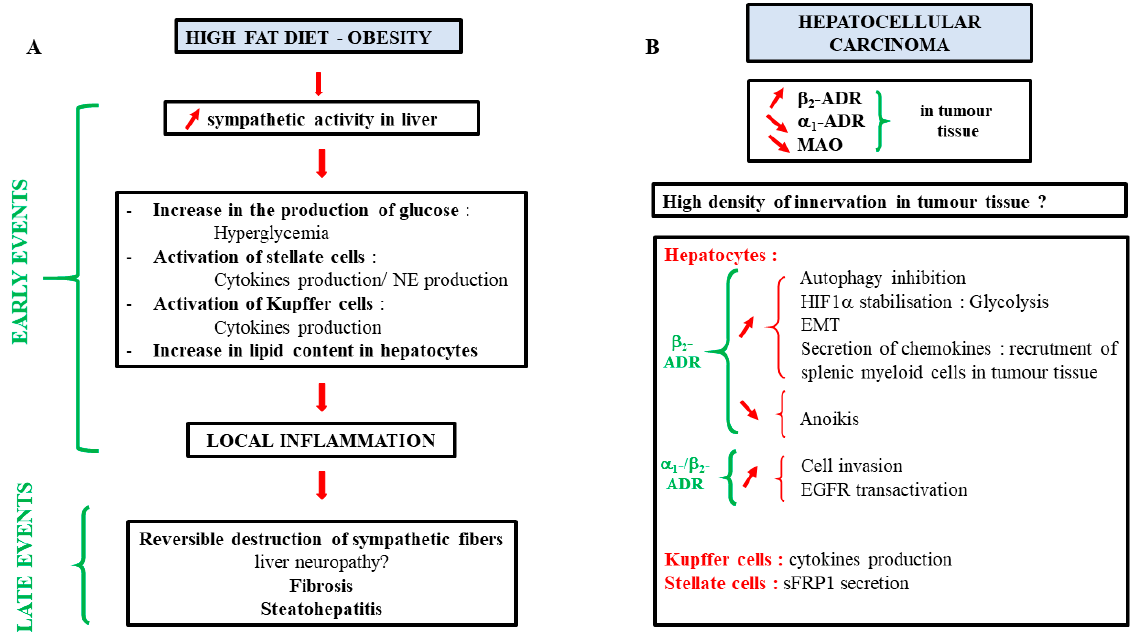
Figure 6. Summary of catecholamines liver effects during a high fat diet or obesity ( A ) and on HCC progression ( B ). ( A ) During high fat diet or obesity, an increase in liver sympathetic activity is ob-